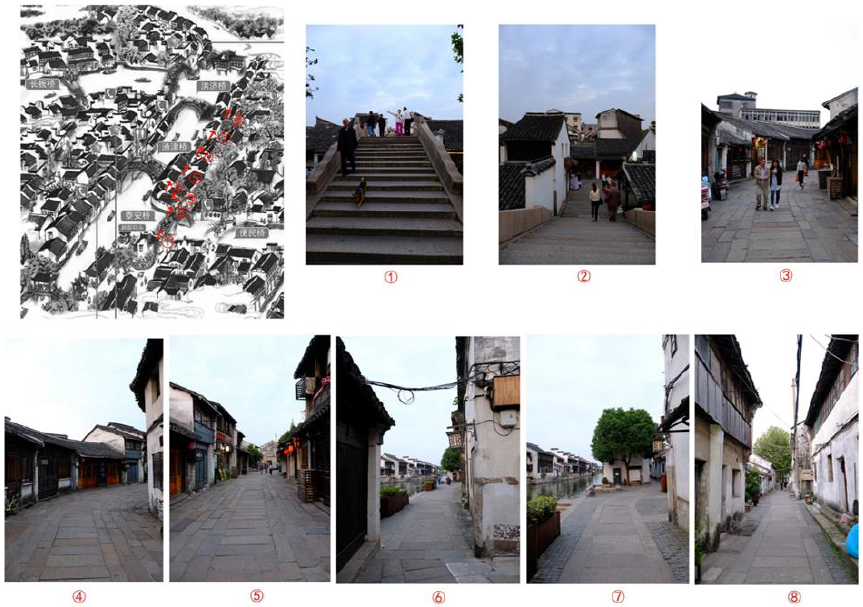
Figure 5. Serial vision of Baoshan historical block in Nanxun ancient town area.